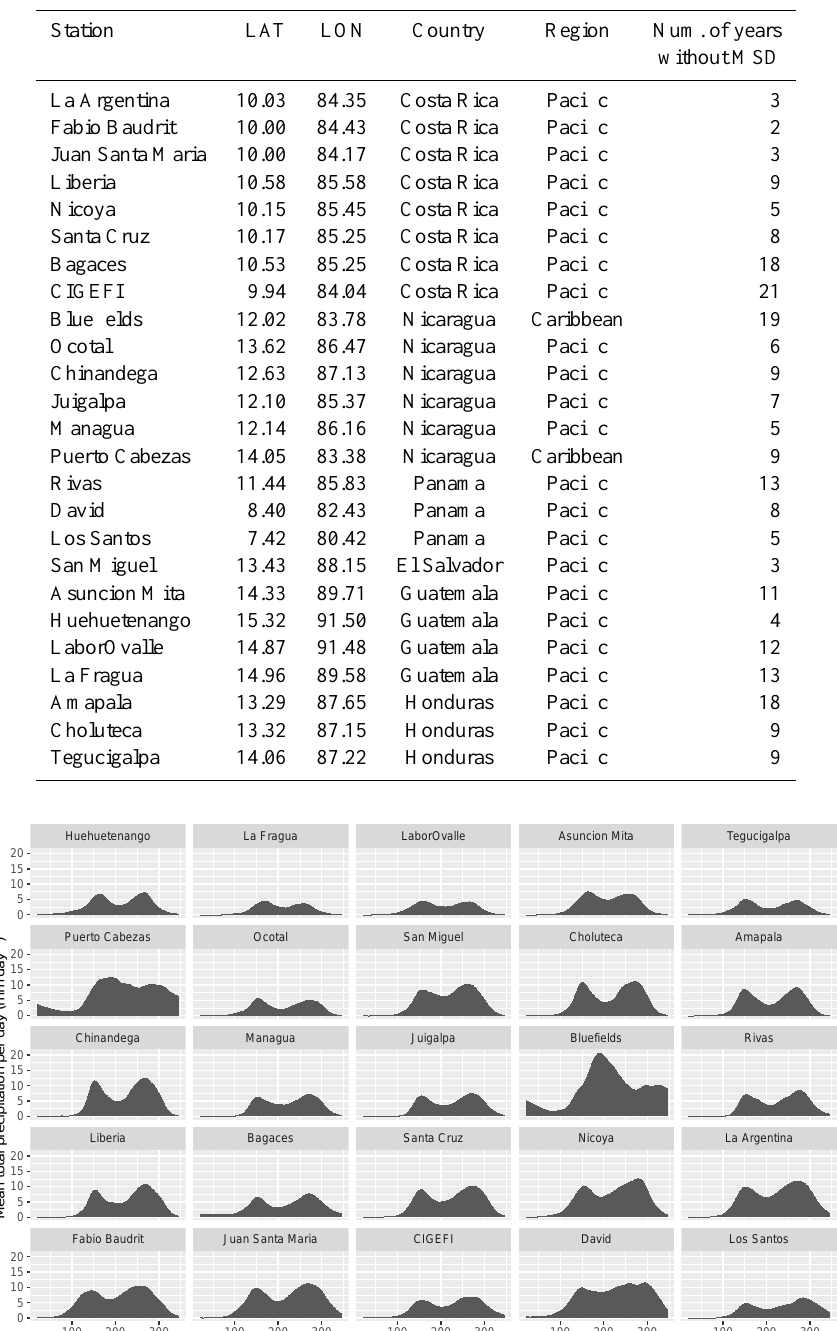
and relevant features of the MSD by means of empirical con- tingency tables for conditional